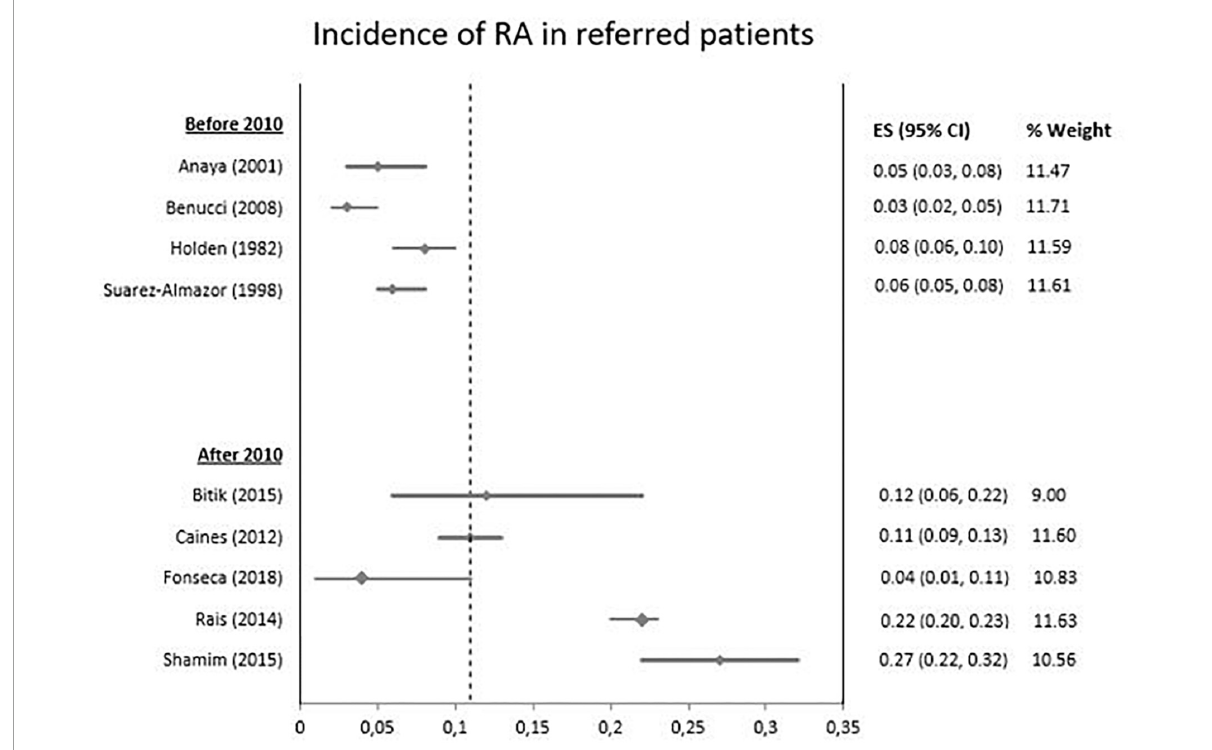
FIGURE2 Incidence of rheumatoid arthritis in patients referred to a rheumatologist based on year on study.